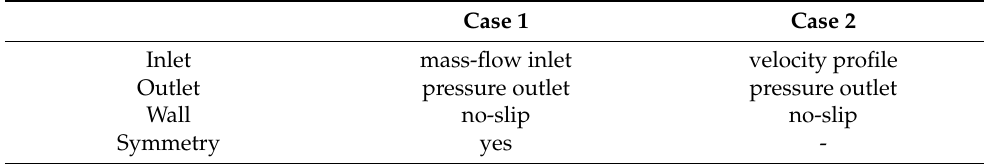
Table 3. Boundary conditions for the two considered cases.